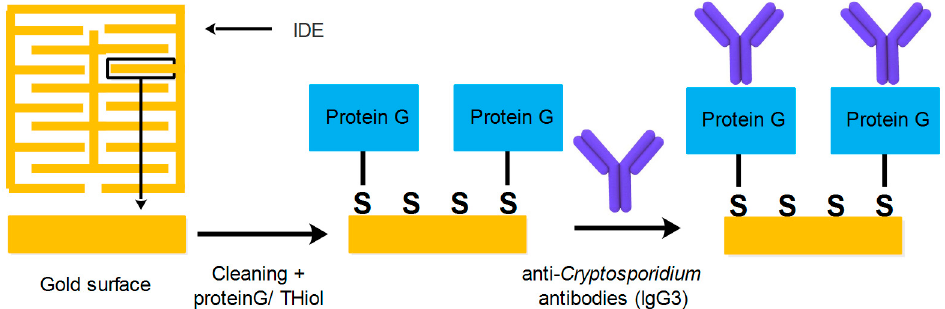
Figure 2. The process used for coating the surface of IDE with SAM and the immobilization of anti- Cryptosporidium antibodies.